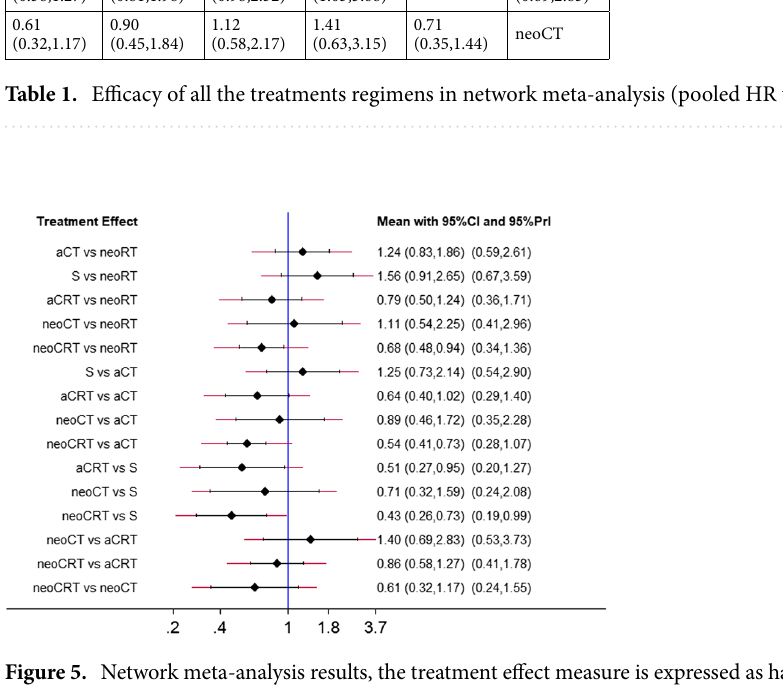
Figure 5. Network meta-analysis results, the treatment effect measure is expressed as hazard